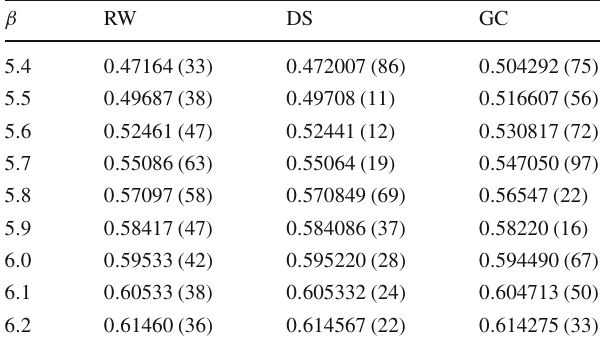
Table 1 The average value for the spatial plaquette, from HDQCD simulations at 6 3 × 6, κ = 0 . 12 and μ = 0 . 85, using reweighting, dynamic stabilisation and gauge cooling. Reweighting data have been taken from [40,59,64]